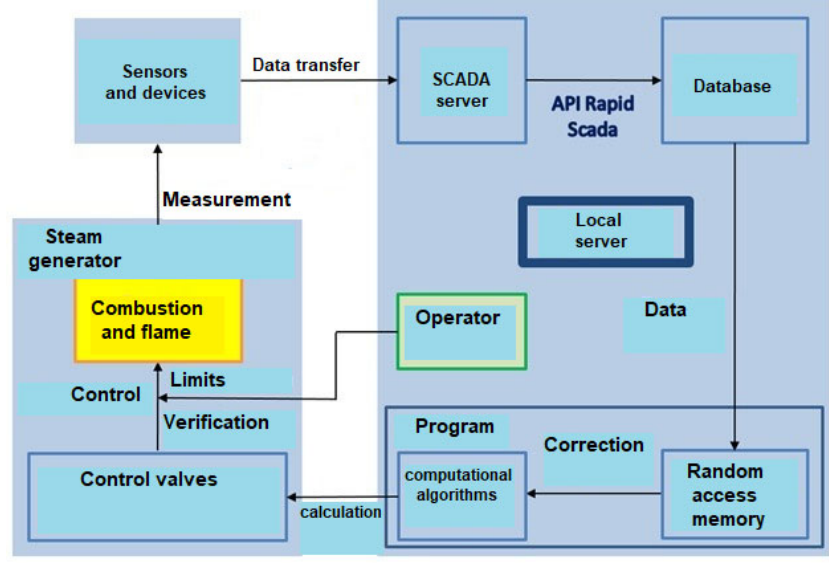
Figure 1. Data transfer scheme.